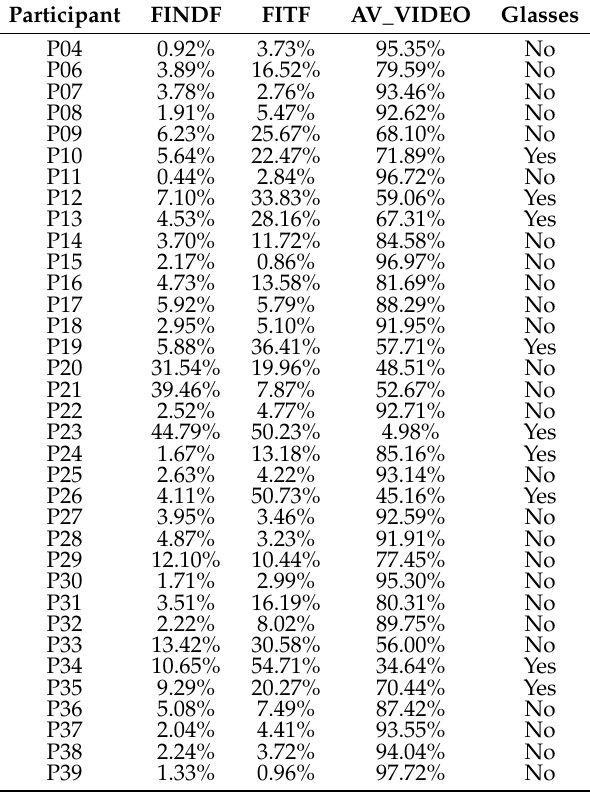
Table 2. Availability of video-based emotion recognition.